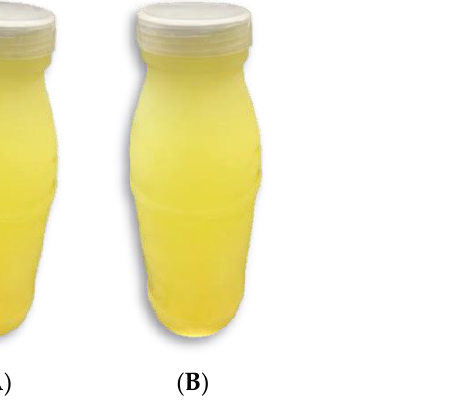
Figure 5. Commercially available sterilized liquid egg white ( A ) and sterilized liquid egg white supplemented with 1% egg white hydrolysate ( B ). Table 4. Color analysis of non-sterilized liquid egg white (NSLE), sterilized liquid egg white (SLE), and SLE supplemented with 1%, 3%, or 5% egg white hydrolysate (EWH).